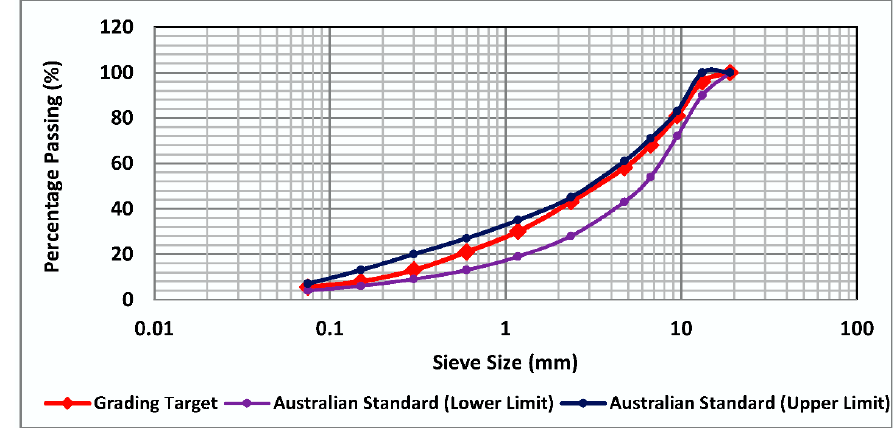
Figure 2. Gradation curve of asphalt mixtures.